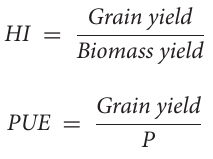
aboveground biomass, plants were fixated at 105 ◦ C for 0.5 h